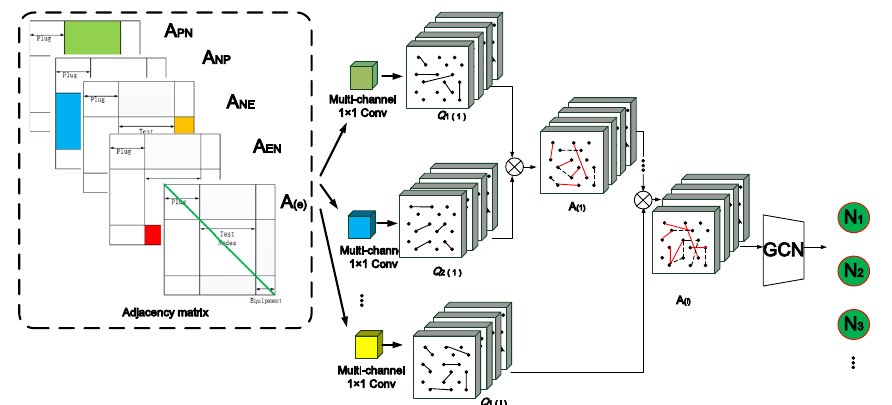
Fig. 6 GTN learn to generate a set of new meta-path adjacency